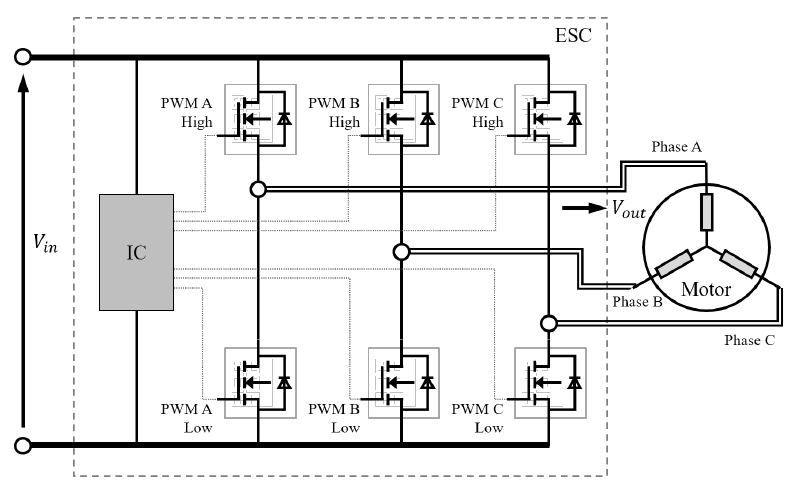
Figure 6. Equivalent circuit of the electric speed controllers (ESC).